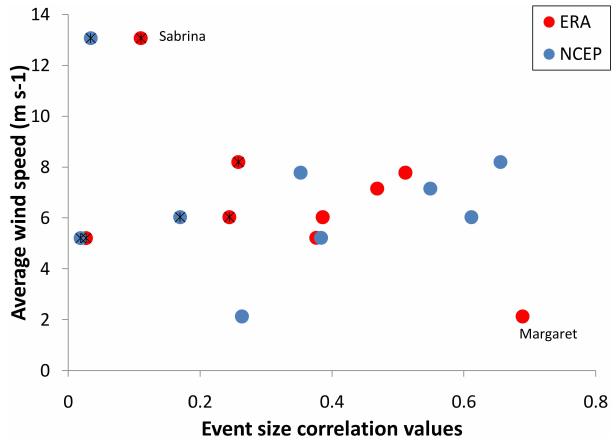
Fig. 6. Relationship between near-surface wind speed and event size correlation values (from Fig. 5), including those not signifi- cant at > 90% level (indicated with asterisk). Wind speed values are derived from ERA-Interim 850hPa monthly averages (750hPa for Byrd), averaged over the period of this study (2008–2012). Sta- tions with the highest (Sabrina) and lowest (Margaret) wind speed are